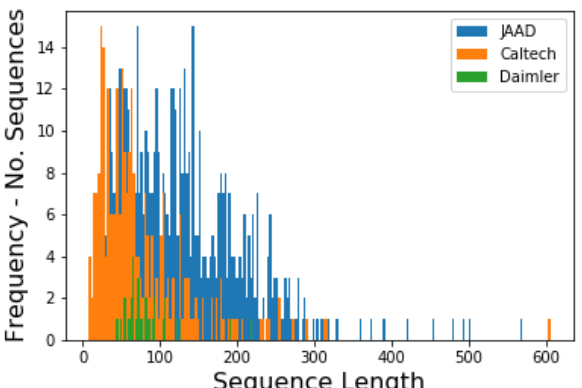
Figure 3. Distribution of sequence length on cropped pedestrian images.